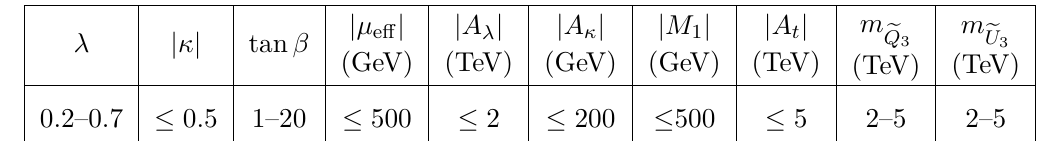
Table 1. Ranges of various model parameters adopted for scanning the Z 3 -NMSSM parameter space. The fixed values of various soft parameters used are as follows: m A b,τ = 3 TeV, M 3 = 3 TeV and M 2 = 2 . 5